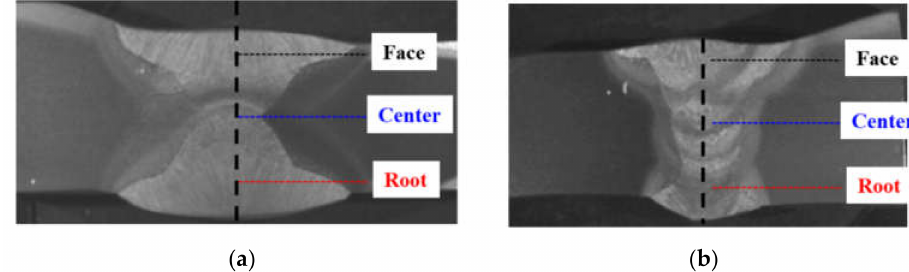
Figure 6. Position of specimens in hardness test: ( a ) SAW (B1) and ( b ) FCAW (B5).